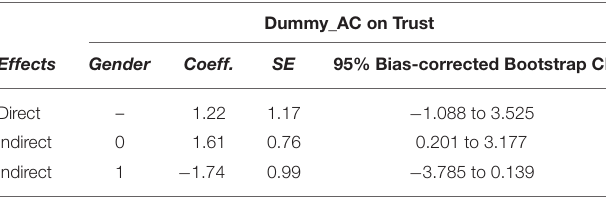
TABLE 2 | Direct and conditional indirect effects of the experimental condition on trust in Study 1. Dummy_AC on